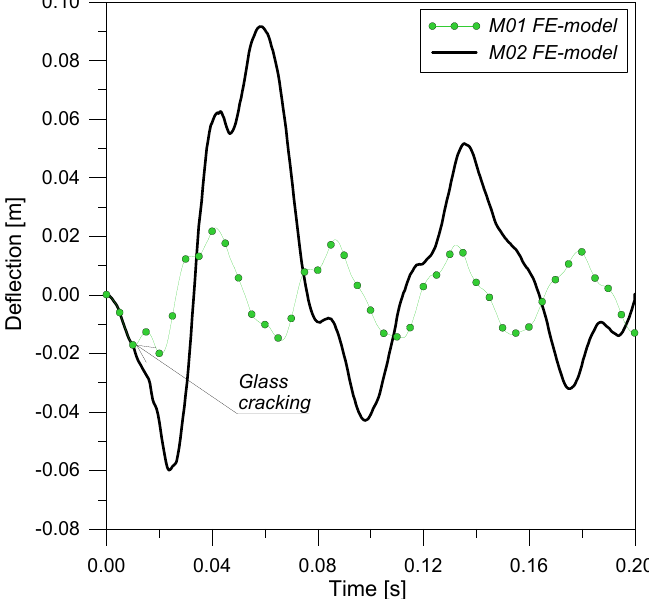
Figure 13. Comparison of deflection at the center of panel (inner glass lite).